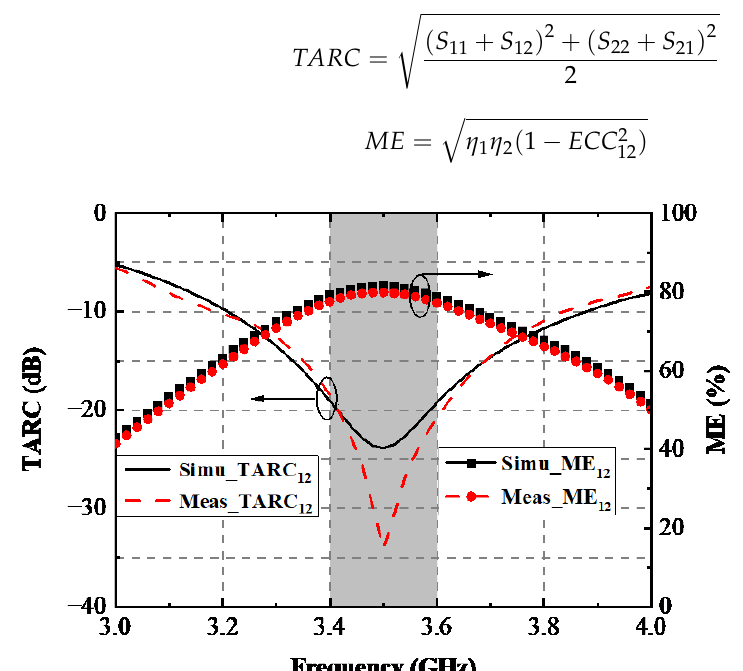
Figure 15. Computed TARC and ME.